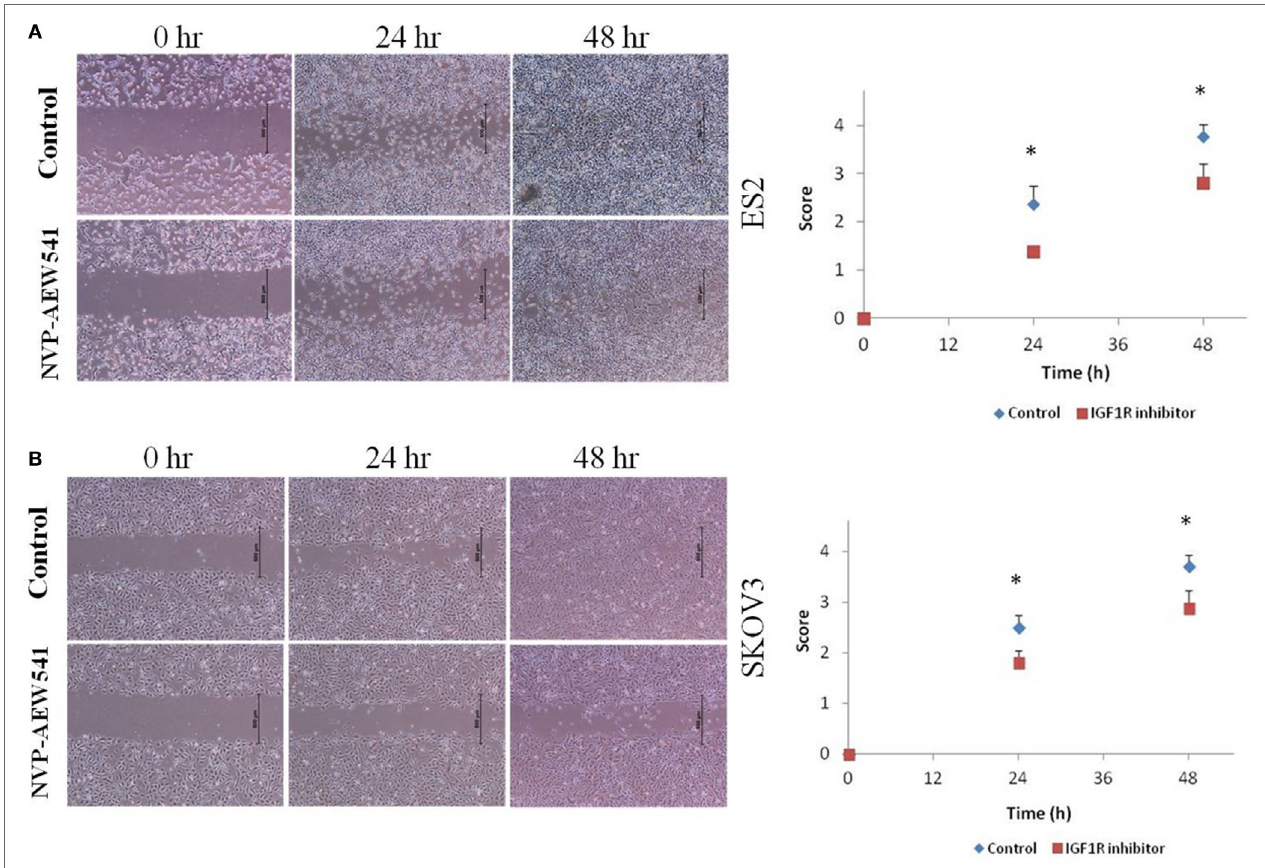
FiGUre 2 | NVP-AEW541 treated dendritic cells decrease ovarian cancer cell migration. Cell migration was detected by wound scratch assay. Representative wound closure images from three experiments are shown. Human leukemic HL-60 cells were treated with 1 μ g/ml of CI and with 2 μ M of NVP-AEW541 for 72 h after which they were co-cultured with the epithelial ovarian cancer (EOC) cells ES2 (A) and SKOV3 (B) . Scratch was applied 24 h post cell merge. The growth of EOC cells into the scratch zone is demonstrated here at time 0, 24, and 48 h after scratch. The graphs represent average growth score of three independent experiments of ES2 and SKOV3 cells (* P <